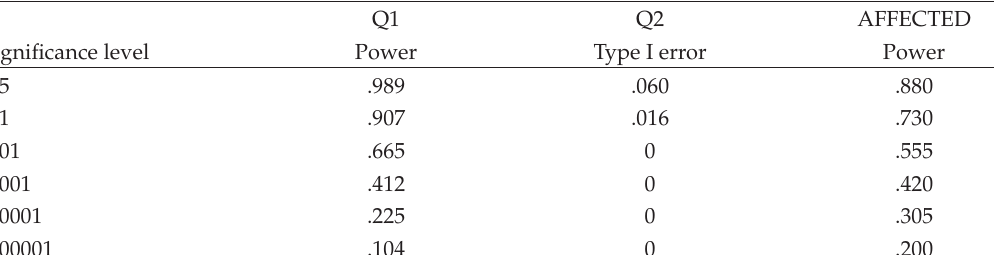
Table 1: Nominal significance according to VEGFC .